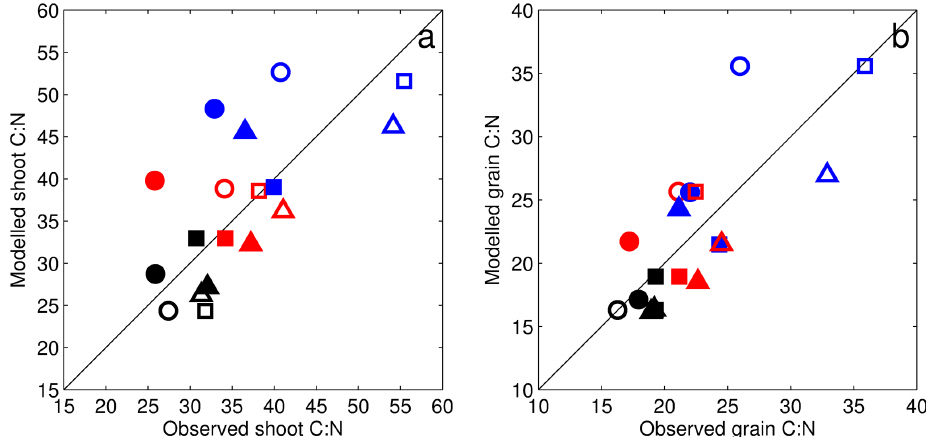
Figure 4. A comparison between modelled and observed C : N in harvested above-ground biomass (a) and grains (b) , for the Eest, the Bouwing and PAGV, the Netherlands for the seasons 1982–1983 and 1983–1984. Symbols are the same as in Fig. 2 with blue symbols for low input of N fertiliser, red for a medium input of N and black for high N